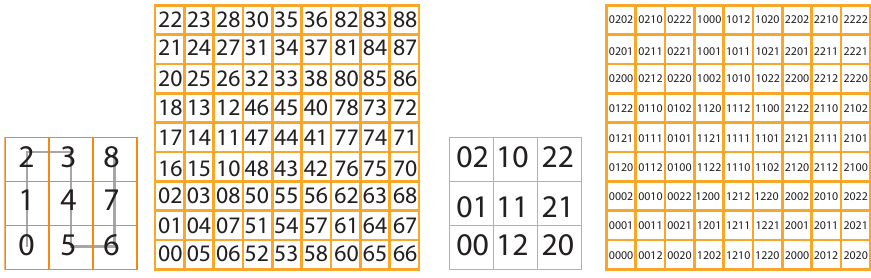
Figure 15. ( Left ) Indexing of quadrilateral one-to-nine refinement at two successive resolutions using the Peano SFC with base nine; ( Right ) the same indexing, but with base